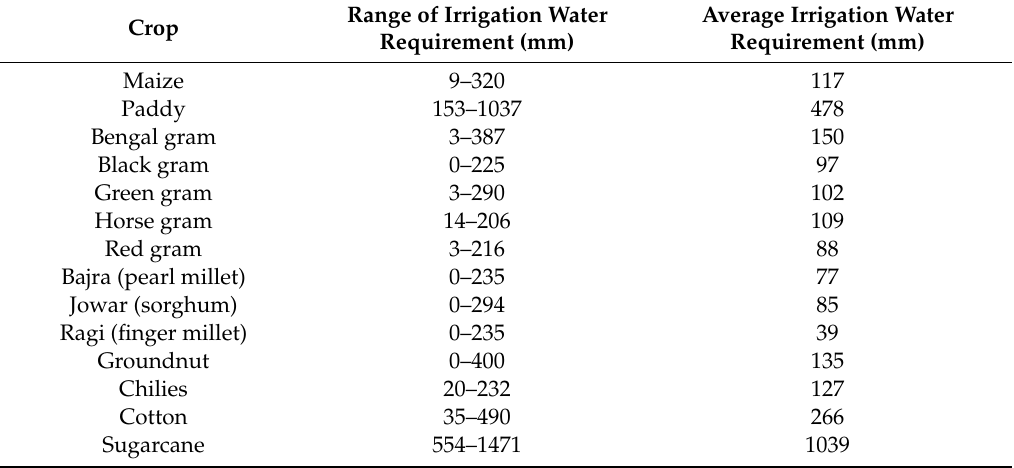
Table 3. Irrigation water requirement for major crops cultivated in the study area. The numbers listed represent the range (minimum to maximum) and average across the entire